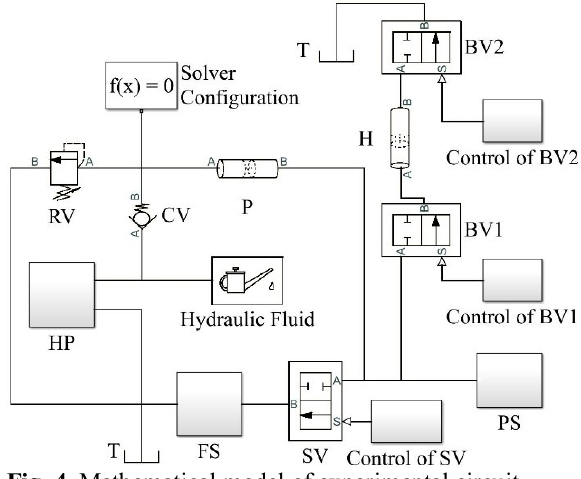
Fig. 4. Mathematical model of experimental